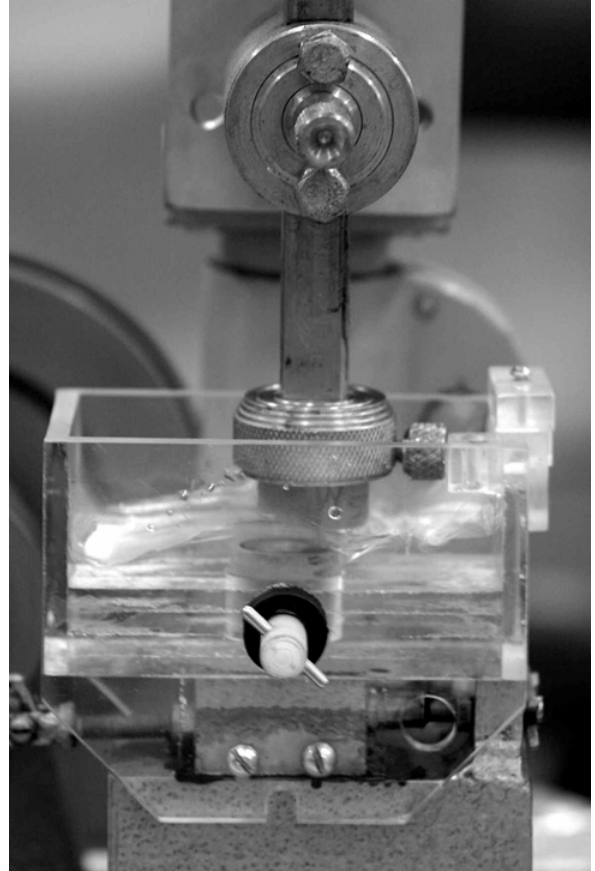
FIGURE 2- Wear abrasion test